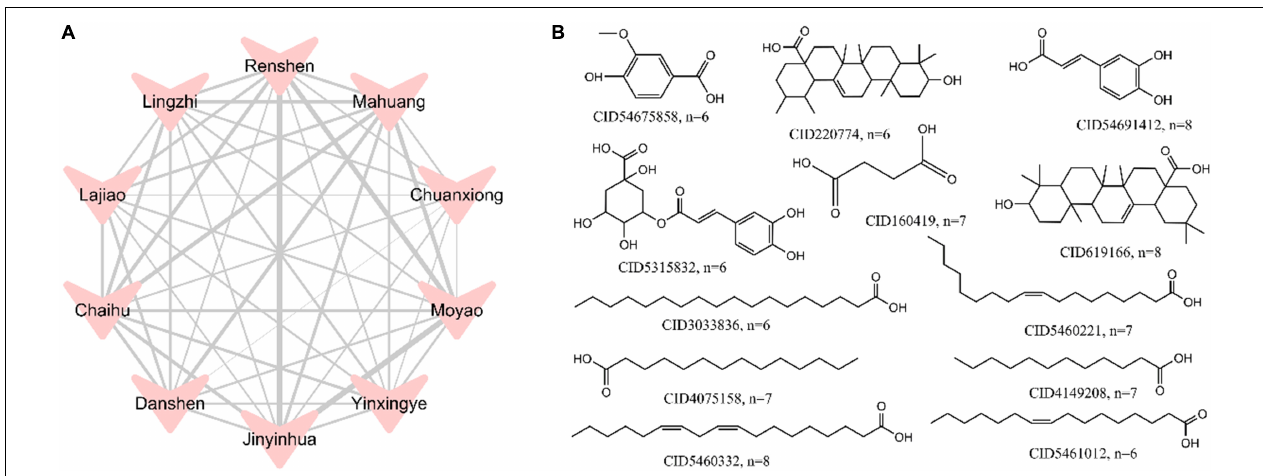
FIGURE 4 | A herb-herb (H-H) network of the top 10 herbs (A) and the structures of 1,042 hepatotoxic compounds with frequency greater than 6 (B) . The width of lines was based on the number of duplicate compounds between two herbs, which was proportional to degree.